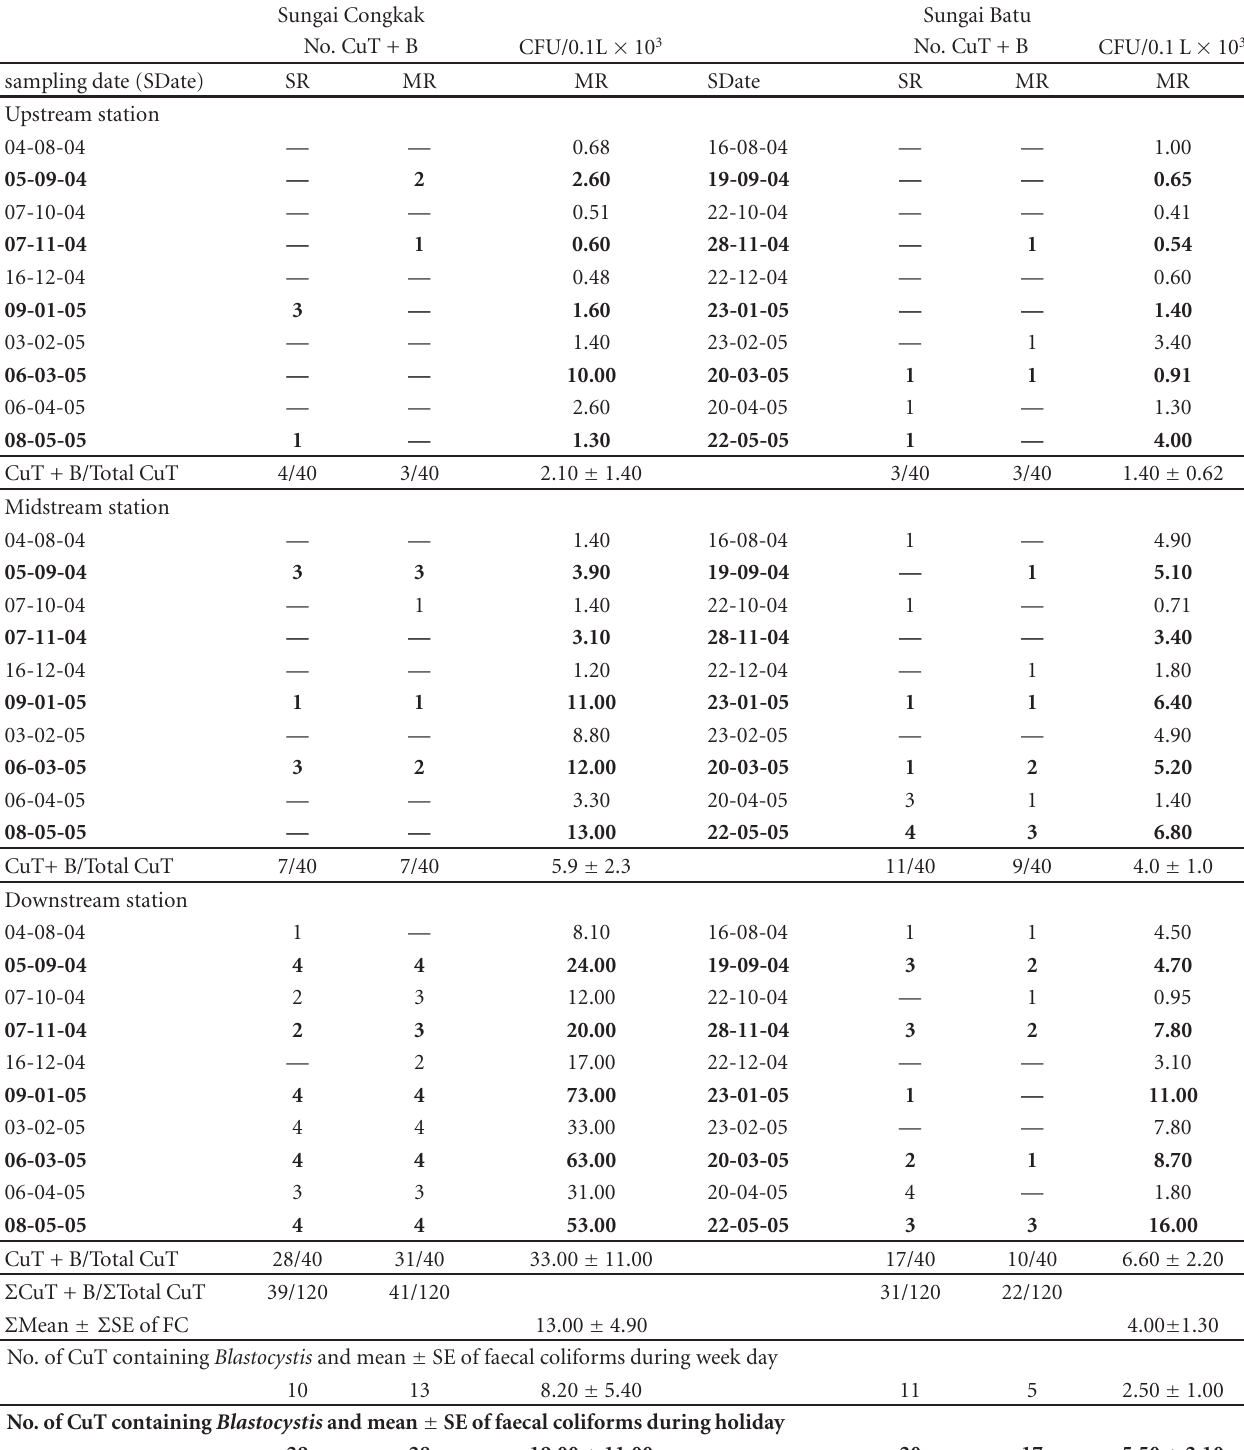
Table 3: Number of culture tube containing Blastocystis and faecal coliforms count at the up-, mid-, and downstream sampling sites of the